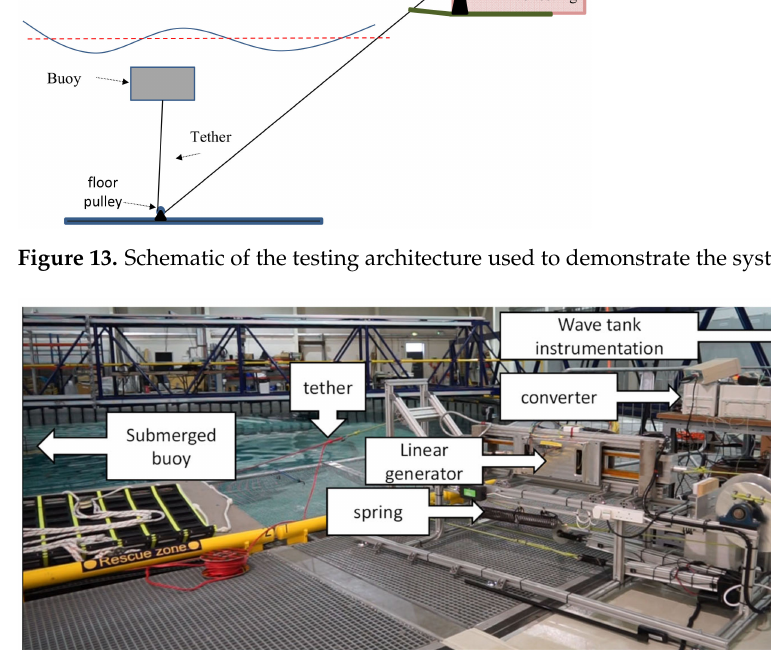
Figure 14. Full system scale testing